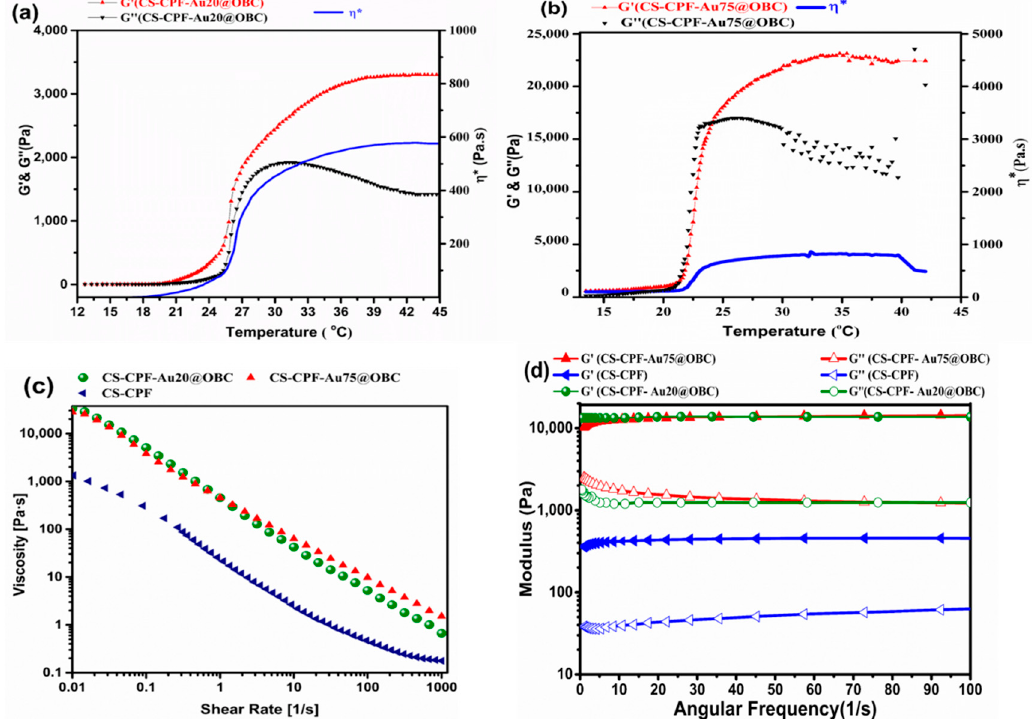
Figure 6. Results of temperature sweep tests for hydrogels containing ( a ) 20 mM and ( b ) 75 mM AuNP concentration. ( c ) Variation in viscosity versus the shear rate demonstrates the shear-thinning behavior of the hydrogels. ( d ) Results of frequency sweep tests.